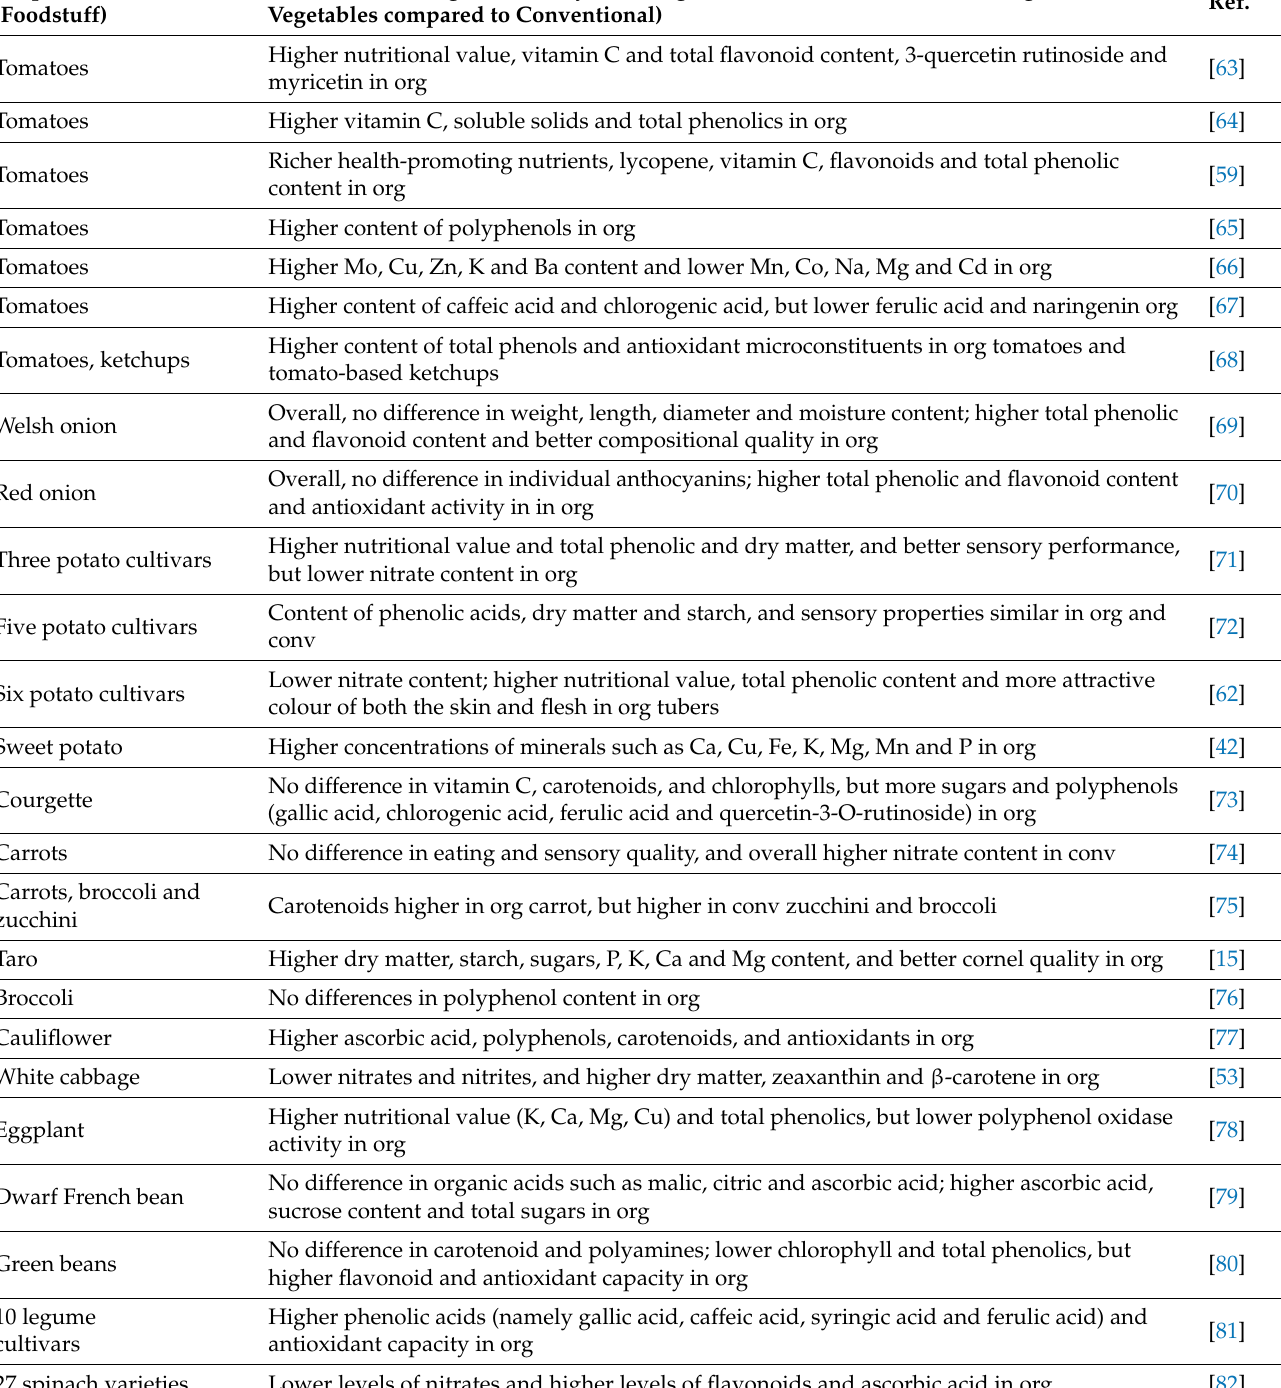
Table 1. Comparison of the quality and nutritional parameters in organic and conventional fruits and